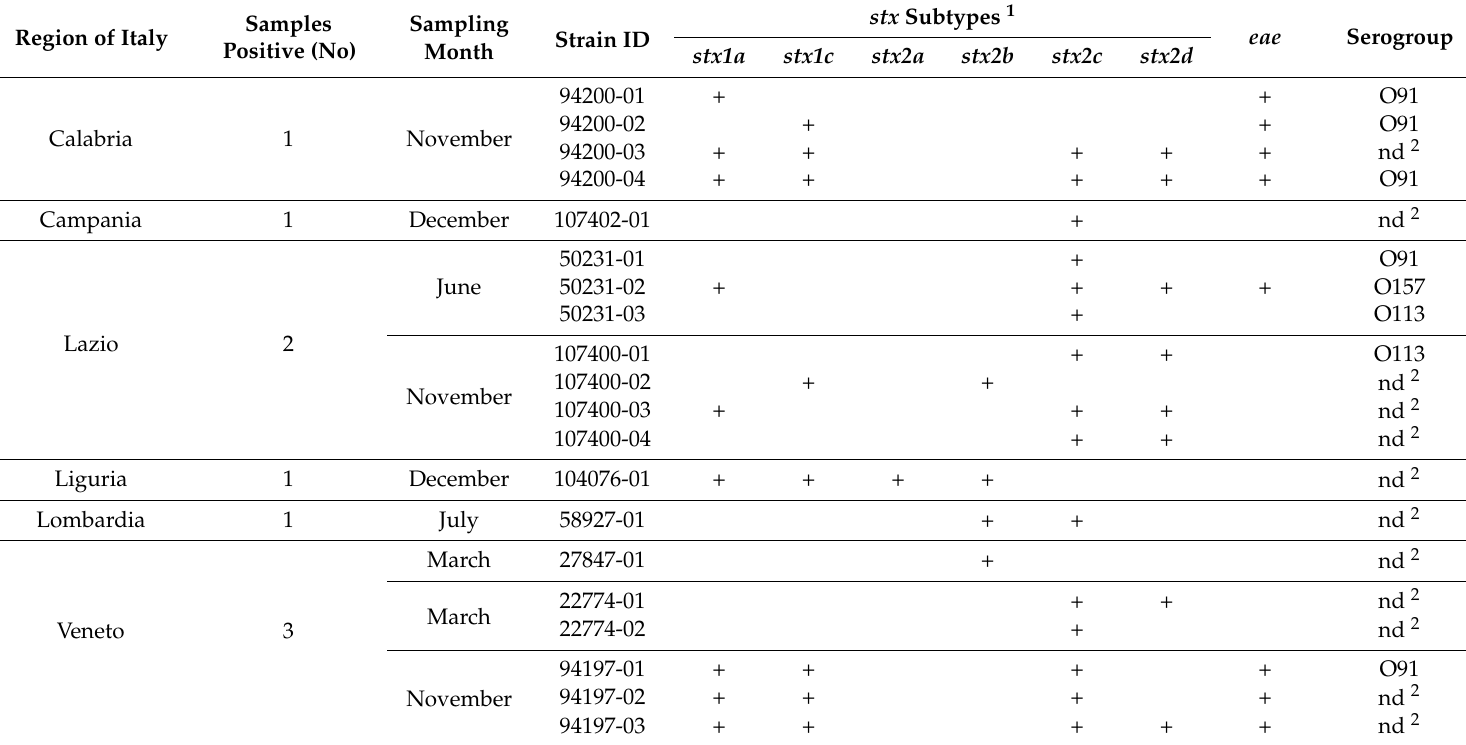
Table 2. Subtyping of Shiga-toxin stx1 and stx2 genes and serogroups associated with STEC strains isolated from fresh beef samples collected within 13 regions of Italy